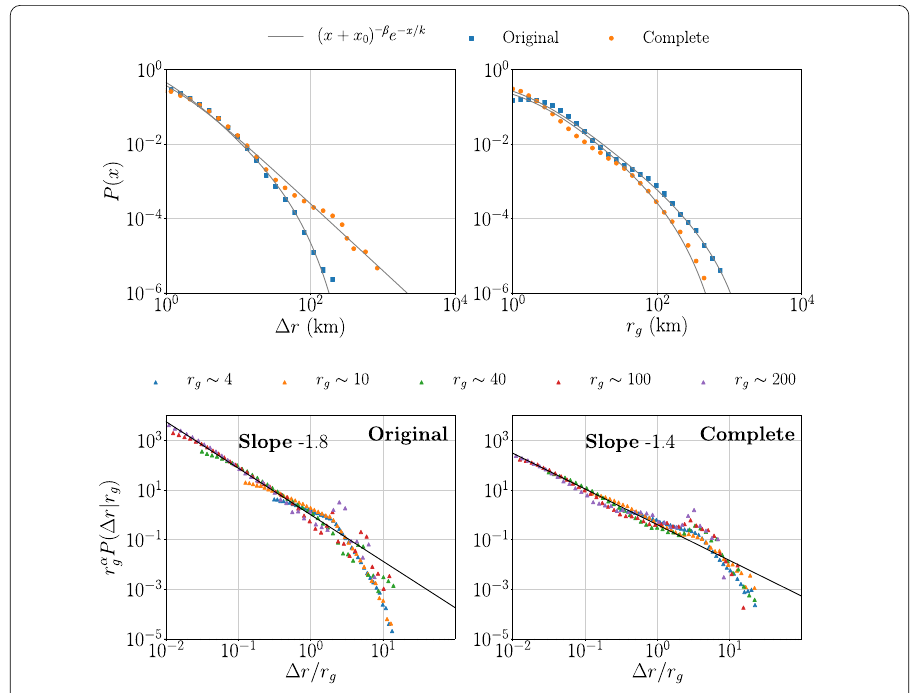
Figure 9 Revisited results from [3]. Distributions of travel distance (cid:6) r , radius of gyration r g , and conditional travel distance (cid:6) r (with respect to (cid:6) r / r g ) for original and complete trajectories